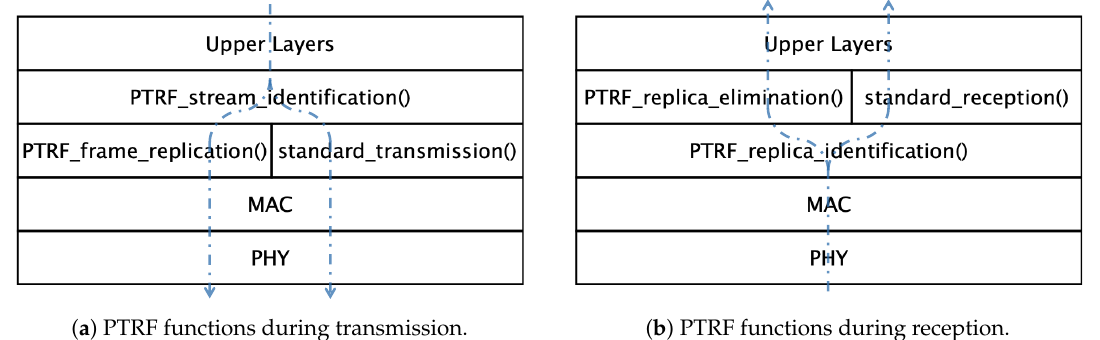
Figure 9. Functions of the PTRF mechanism in reception and